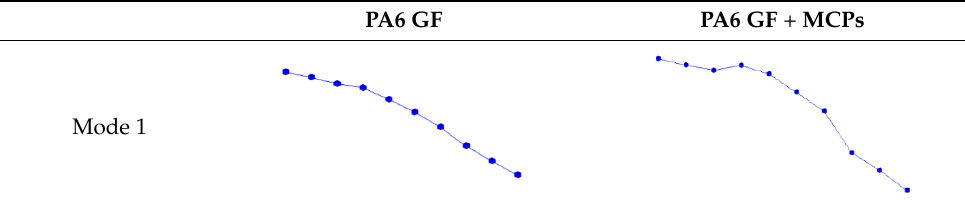
Table 5. Mode shapes of roof rack specimen.